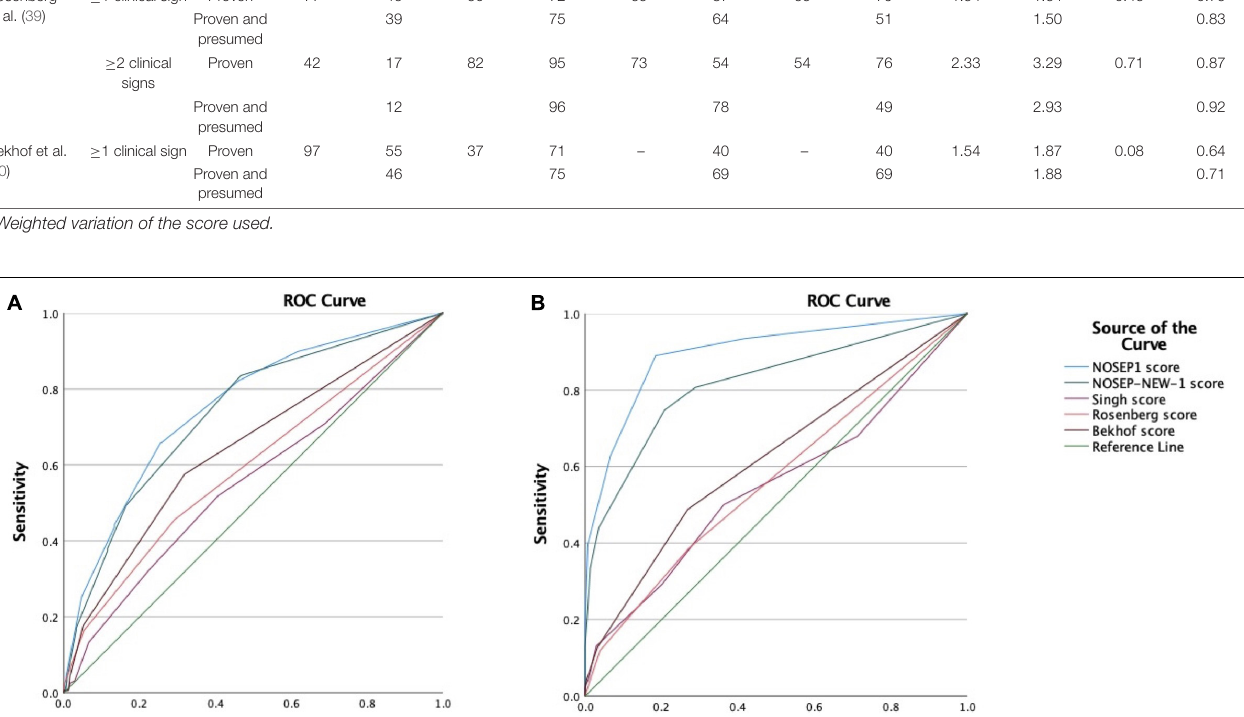
Frontiers in Pediatrics |